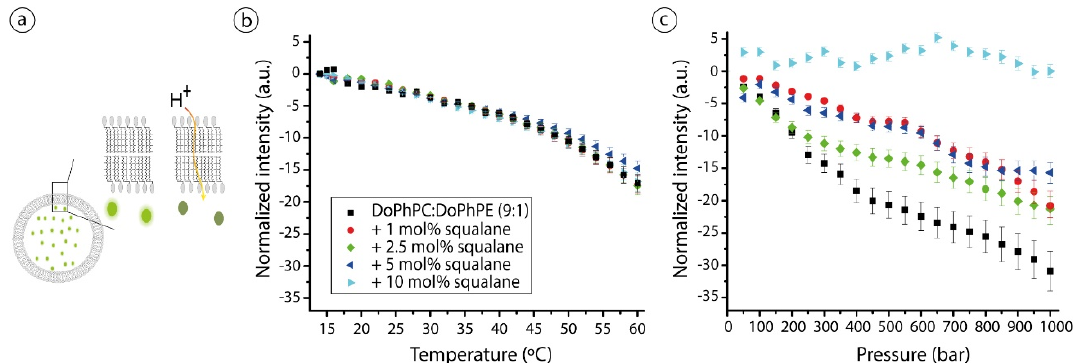
Figure 3. ( a ) Schematic representation of the pyranine technique to measure pH inside vesicles. Initially, pyranine is encapsulated in the liposomes and the entrance of protons will cause a decrease on pyranine fluorescent intensity. The size of probes is not at scale. ( b ) Pyranine normalized intensity inside vesicles as a function of temperature and ( c ) hydrostatic pressure applied on liposomes of DoPhPC:DoPhPE (9:1) in absence (black squares) or in presence of diverse squalane percentages: 1 mol% (red spheres), 2.5 mol% (green diamonds), 5 mol% (blue left triangles) and 10 mol% (cyan left triangles). Data represent triplicate (temperature) or duplicate (high hydrostatic pressure) measurements. No data points were excluded from the